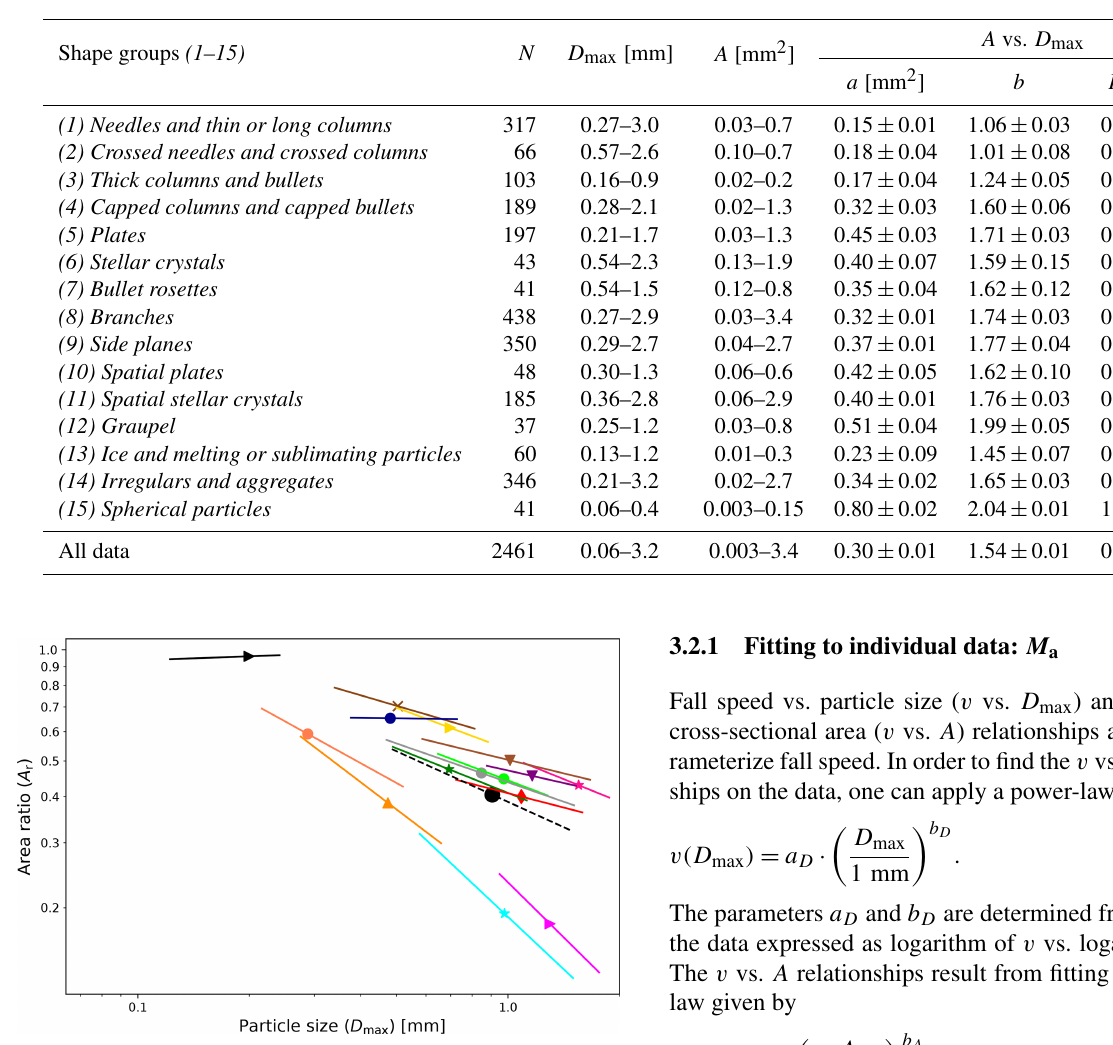
Figure 4. Area ratio vs. particle size ( A r vs. D max ) relationships are shown in logarithmic scale for all the shape groups (solid lines) and all data (dashed black line). The median D max of the data is represented as a single point on each line. The length of the fit lines is defined by 16th and 84th percentiles of D max . For a legend of the shape groups, see Fig.